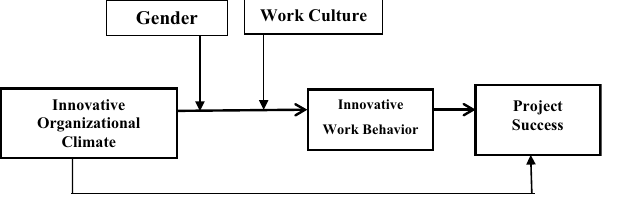
Figure 1. Research